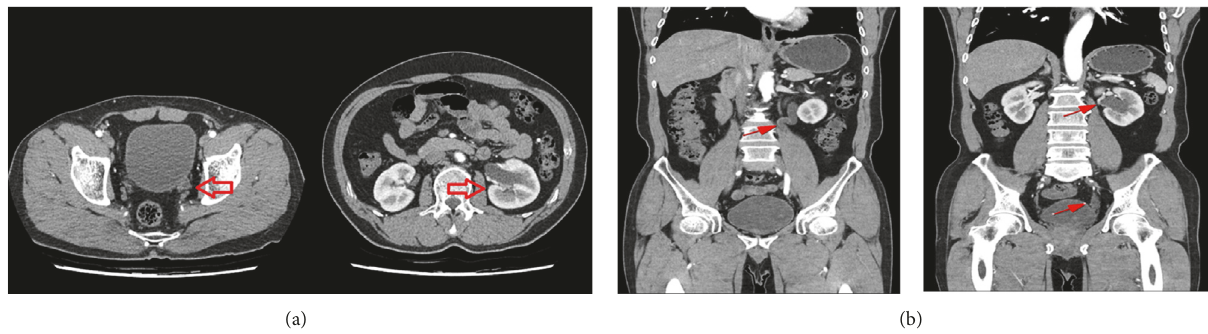
Figure 3: Postoperative follow-up imaging of cystographic computed tomography showing no leakage at anastomosis of ureteroneocys- tostomy with ureteral stent in